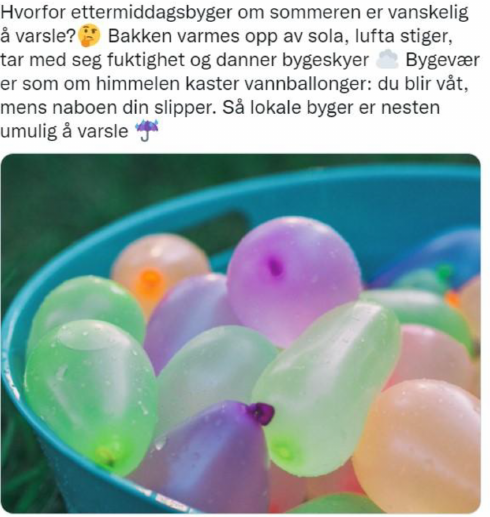
Figure 5. A tweet about local rain showers, comparing them with throwing water balloons. “Why are these afternoon showers so diffi- cult to predict? The sun heats up the ground and the air bring moist to the sky forming rain clouds. Rain Showers like this are as un- predictable as randomly throwing water balloons: you get wet, but your neighbour does not. These showers are local and almost im- possible to forecast.” (our translation). Screenshot by author, from Twitter